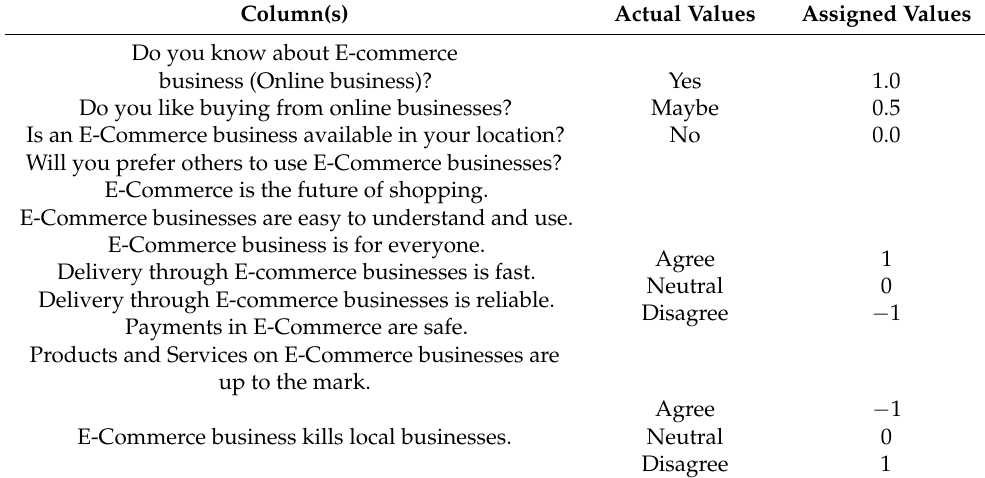
Table 3. Data conversion for e-commerce awareness and loyalty score assignment. Column(s) Actual Values Assigned